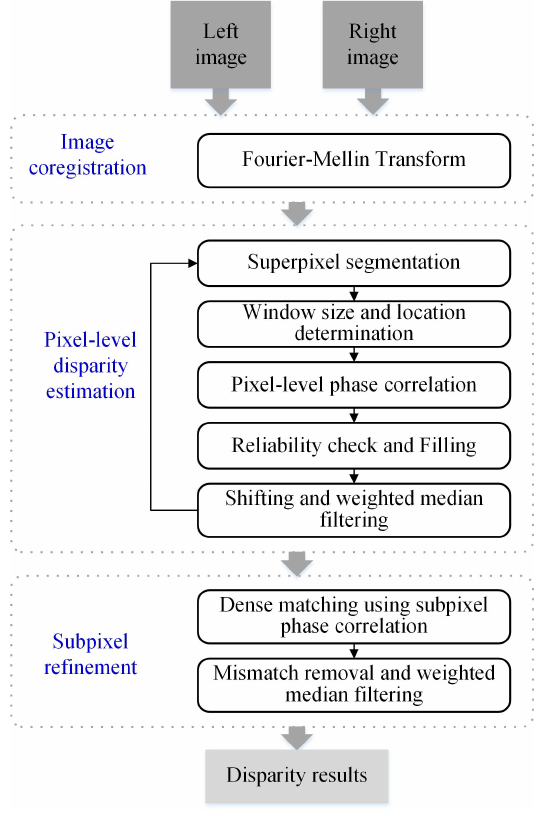
Figure 1. The workflow of the proposed hierarchical and adaptive disparity estimation scheme